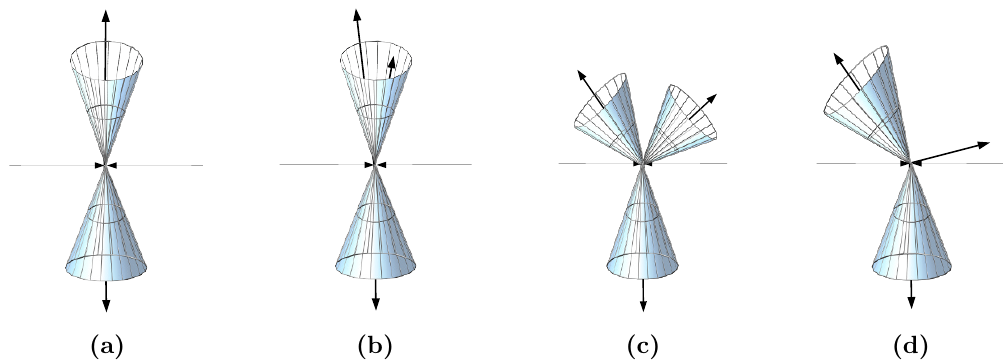
Figure 1 . Illustrations of jet events at LO and NLO with arrows representing partons and cones representing